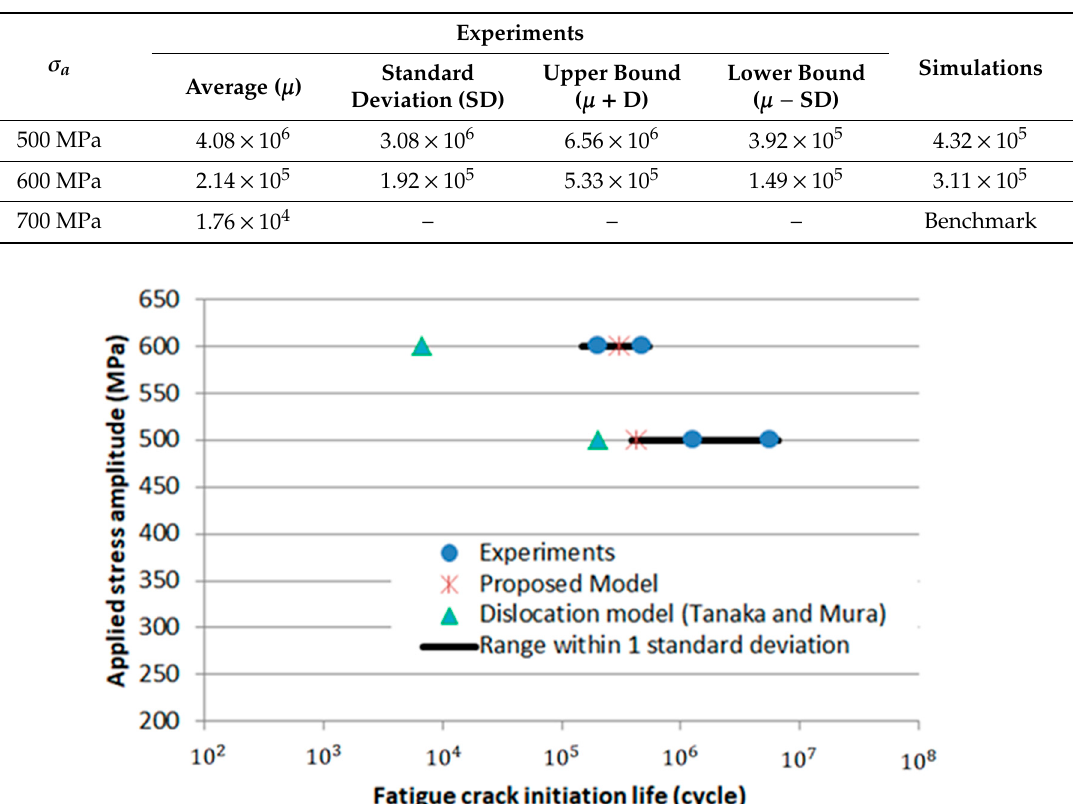
Figure 3. Comparison of fatigue crack initiation life predicted by the proposed model and the Tanaka and Mura model [21]. and Mura model